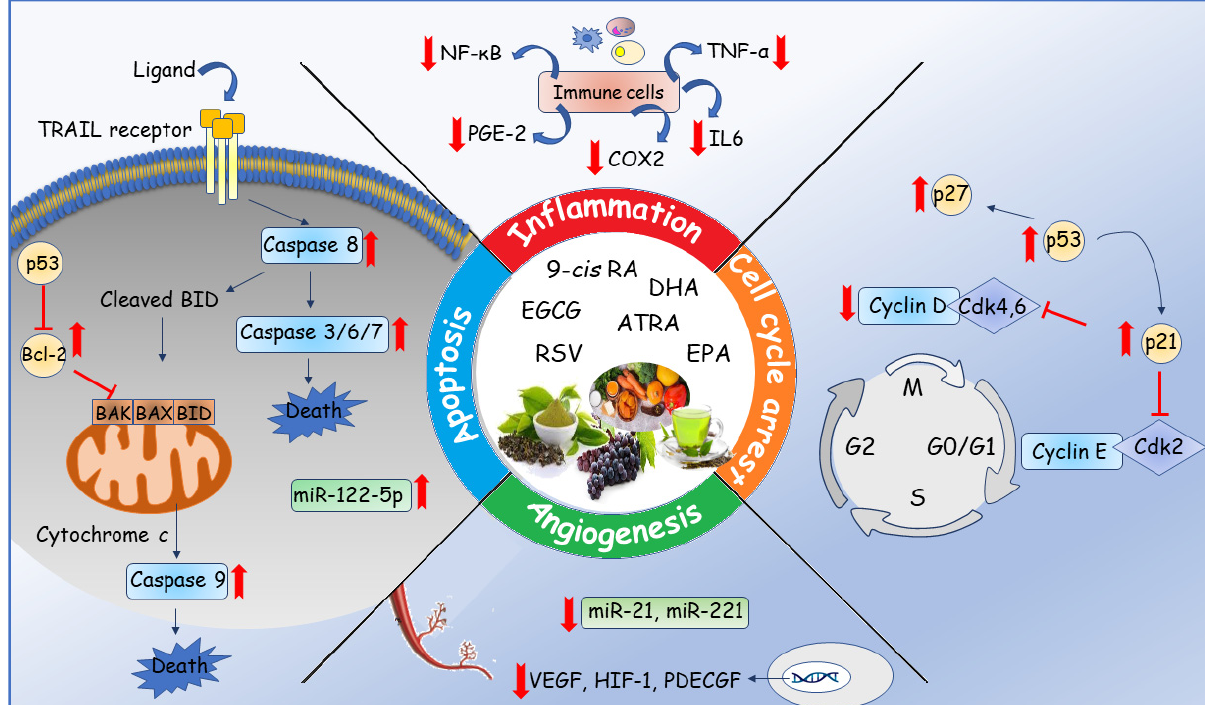
Figure 5. A schematic illustration showing the potential anti-tumoral effects exerted by the nutraceuticals of the MD in the breast cancer progression. Bcl-2: B-cell lymphoma 2; CDK: cyclin-dependent kinase; COX-2: cyclooxygenase 2; HIF-1: hypoxia-inducible factor; IL 6: interleukin 6; miR: microRNA; NF- κ B: nuclear factor kappa-light-chain-enhancer of activated B cells; TNF- α : tumor necrosis factor alpha; PDECGF: platelet-derived endothelial cell growth factor; PGE-2: prostaglandin E2; TRAIL: TNF-related apoptosis-inducing ligand; VEGF: vascular endothelial growth factor.